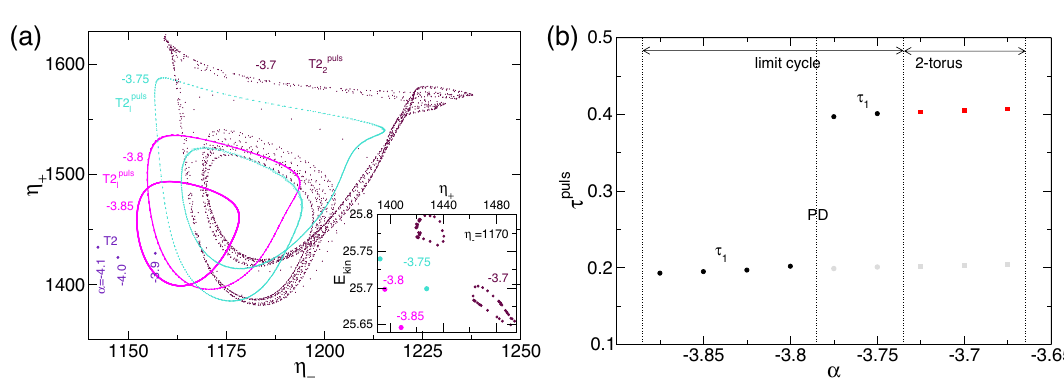
Figure 7. Spacetime plot of the radial velocity u for T2 α 3.7. . Visualizations are shown for three different radial positions, (a) r = − r 1 3 d / 4 . Red (dark gray) and yellow (light gray) correspond to positive and negative values, and (c) r = + respectively.